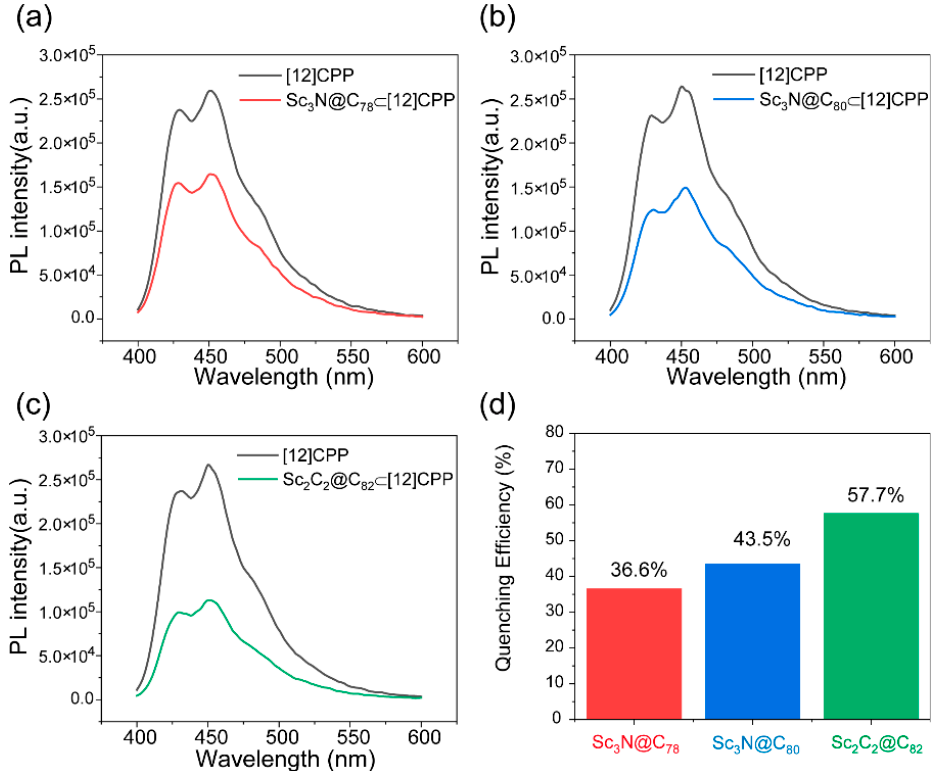
Figure 4. Fluorescence spectra before and after the dropwise addition of ( a ) Sc 3 N@C 78 , ( b ) Sc 3 N@C 80 , and ( c ) Sc 2 C 2 @C 82 to [12]CPP toluene solution at the same concentration. ( d ) Quenching efficiency of [12]CPP by three metallofullerenes at the same concentration.